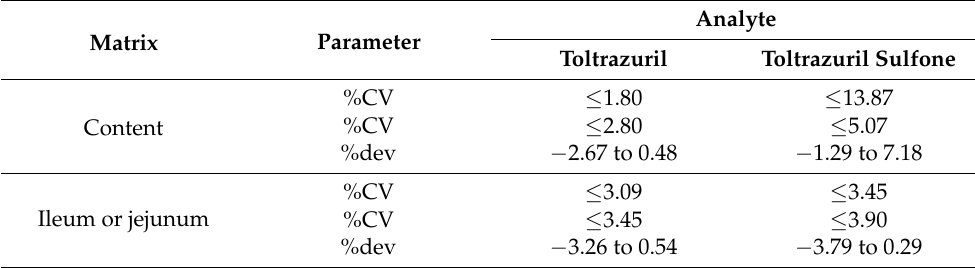
Table 2. The intra-assay precision (%CV), inter-assay precision (%CV), and accuracy (%dev) of the HPLC